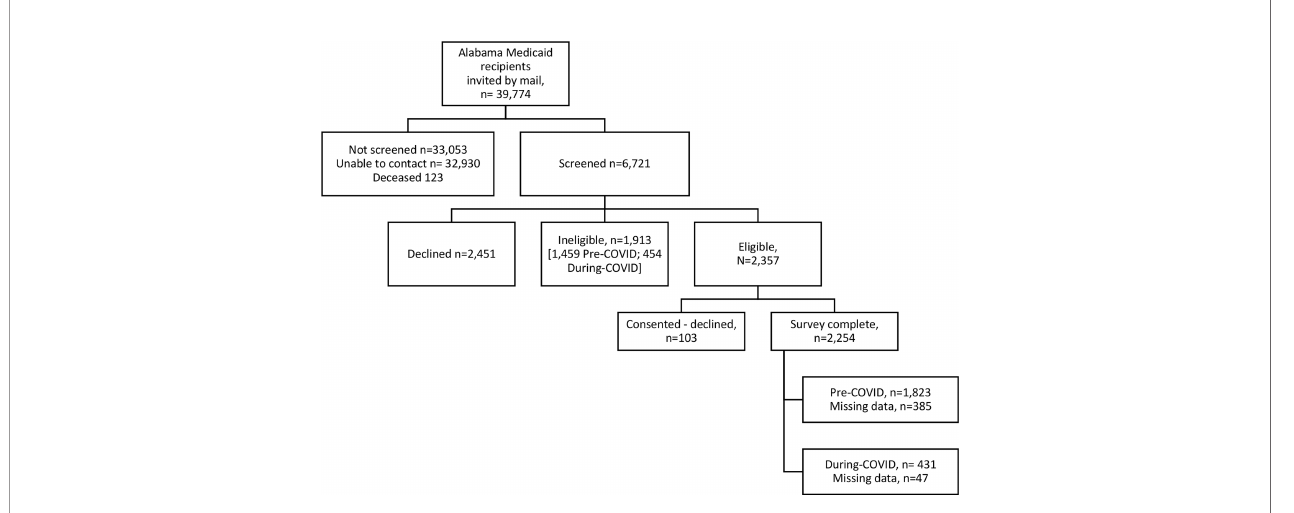
FIGURE 1 | Survey population fl ow diagram of Alabama Medicaid-covered adults with type 2 diabetes mellitus (March 2017 to May